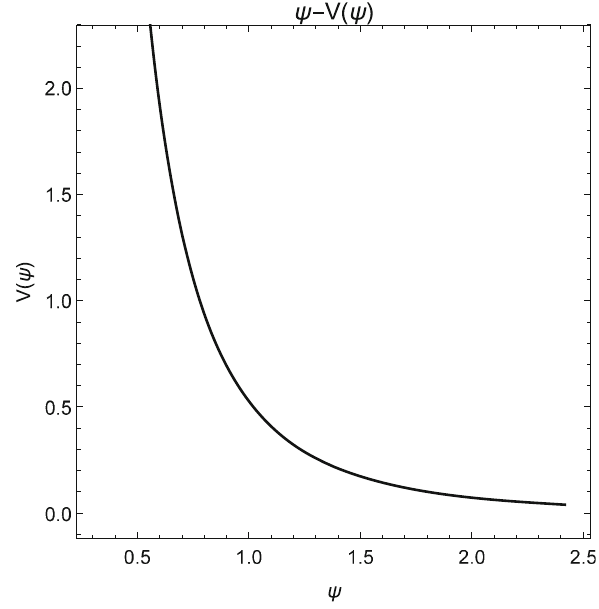
Fig. 3 Qualitative behaviour of the scalar field potential V (ψ) for the intermediated inflation model, plot is for (ψ 1 ,ψ 2 , c θ ,ζ, f , A ) =